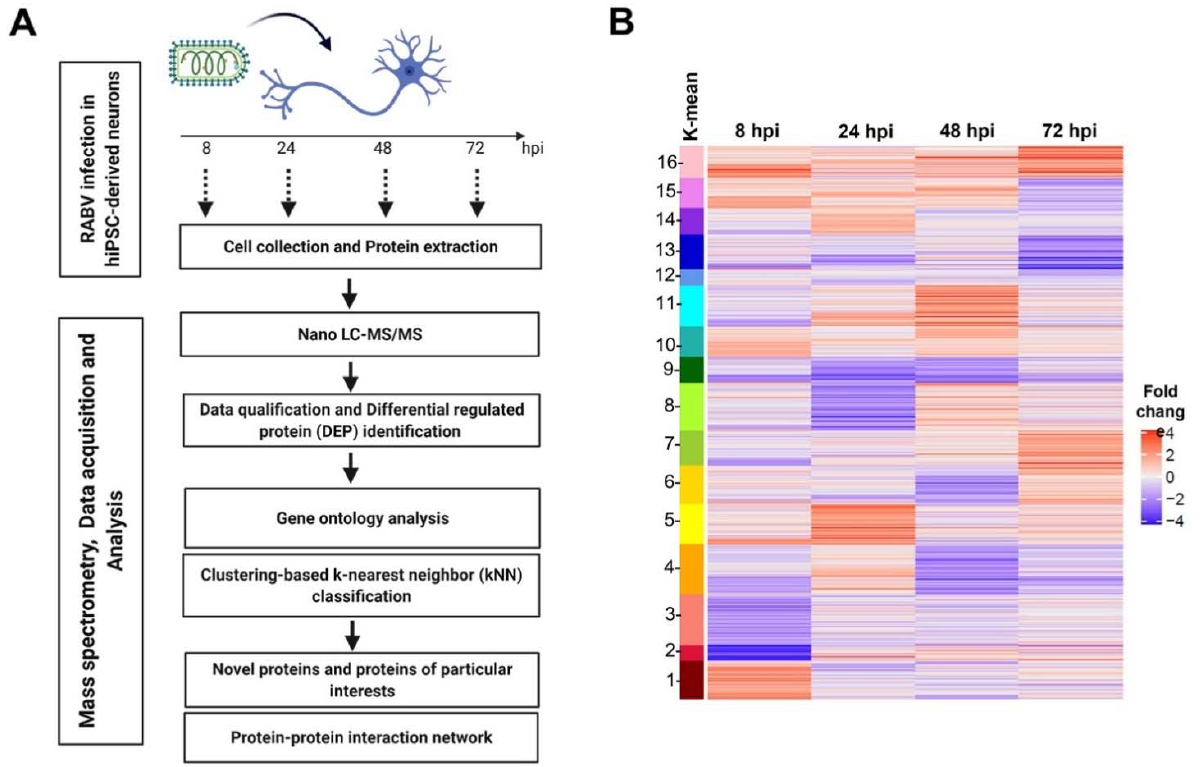
Figure 5. Schematic diagram of proteomic analysis and differential expression protein (DEP) identification in RABV-infected hiPSC-derived neurons. ( A ) Schematic workflows of sample preparation and bioinformatic analysis. ( B ) K-means clustering demonstrated 16 clusters of expressed proteins changing in RABV-infected neurons at 8, 24, 48, and 72 hpi. Table 1. Previously identified DEPs in RABV-infected brain samples and DEPs found in RABV-infected hiPSC-derived neurons.